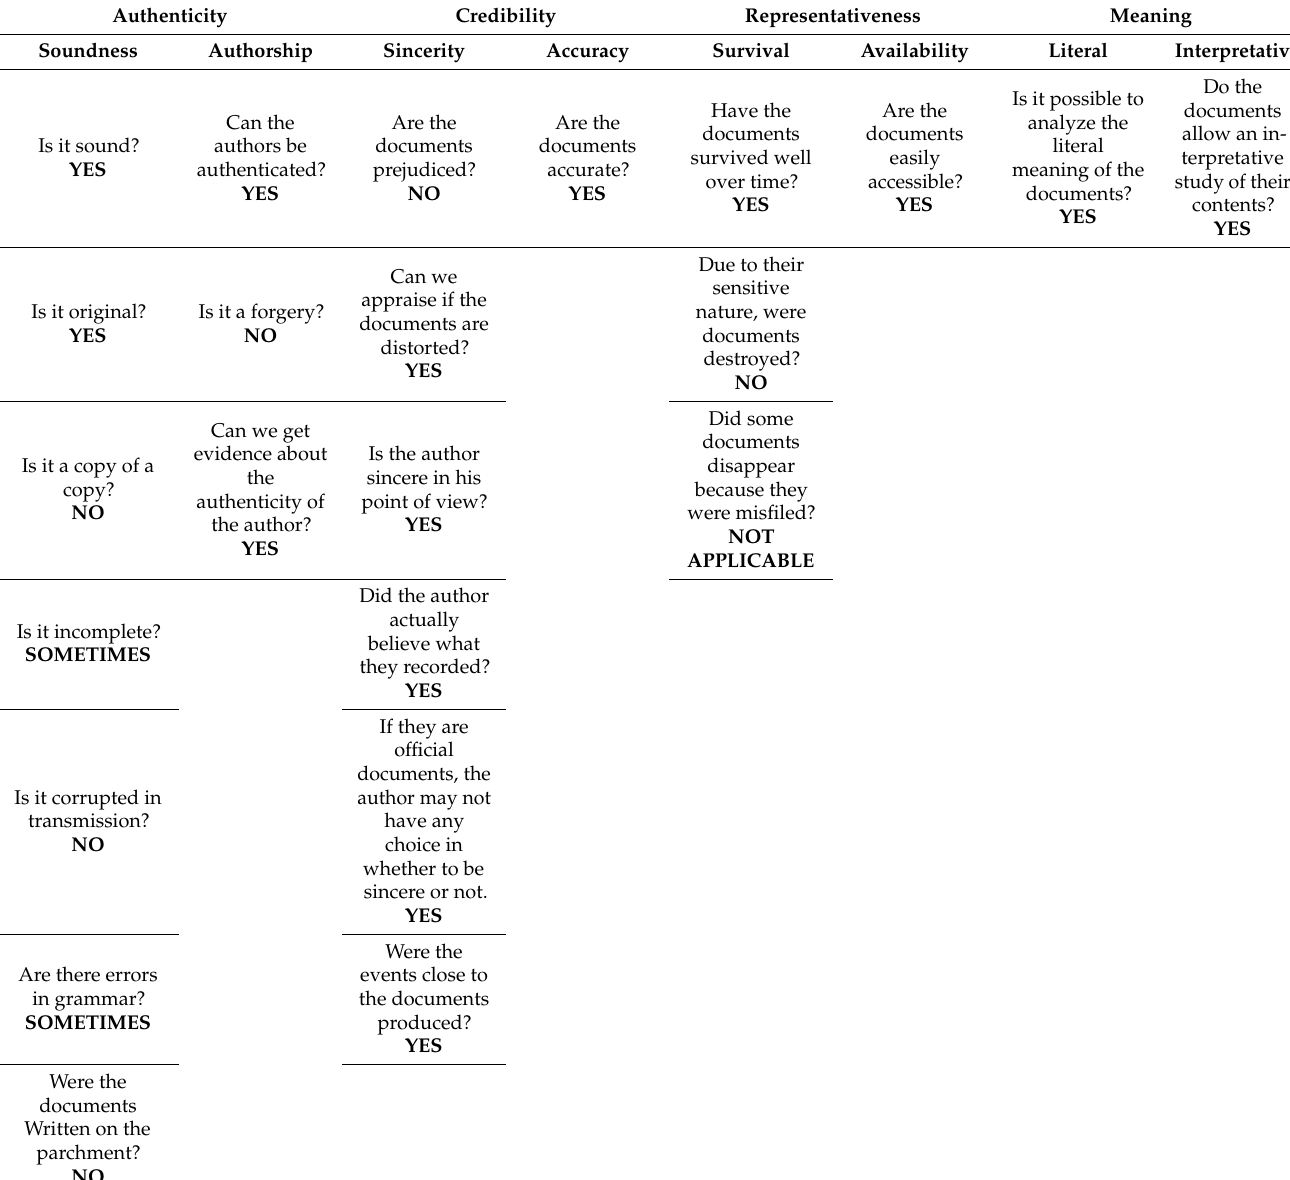
Table 2. Scott’s criteria used in the current